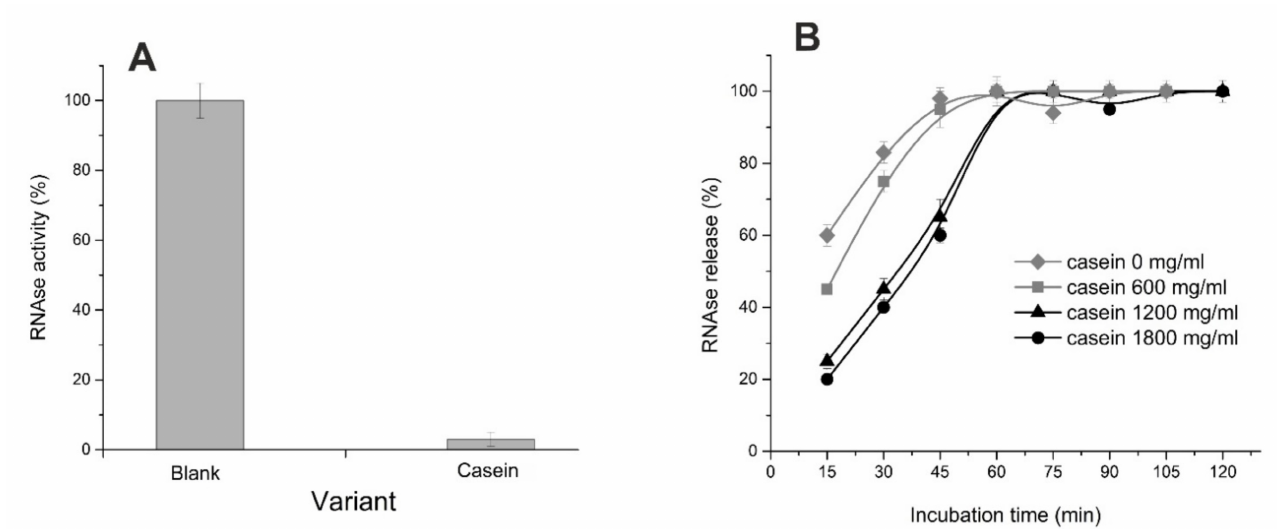
Figure 6. RNase activity in blank solution (300 µ g/mL in 0.01 M PBS pH 7.2) and in solution con- taining 1 mg/mL beta-casein after ultrafiltration through a membrane filter with a pore diameter of 30 kDa ( A ) and time-course of binase release from alginate hydrogel and alginate hydrogel sup- plemented by beta-casein ( B ). 100% of RNase activity of the loaded protein (calculated as difference between the activity of initial solution in 0.01 M sodium phosphate buffer and resting activity after hydrogels incubation) was